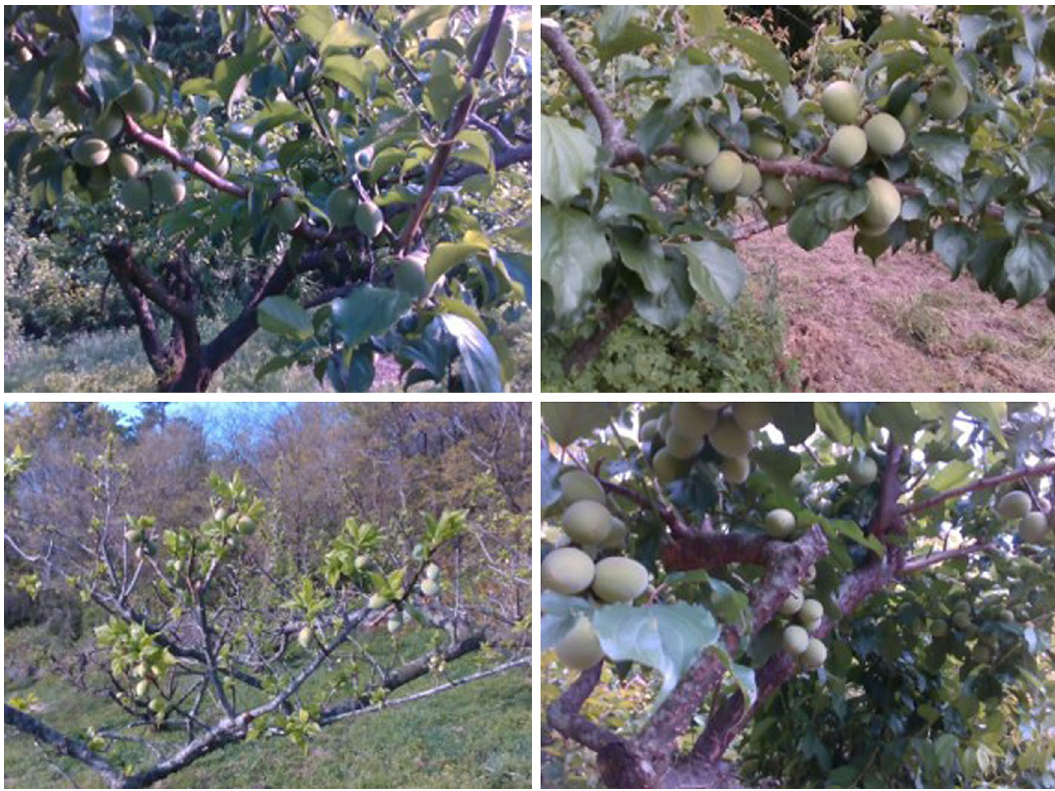
Figure 7. Prunus mume images acquired by the RGBD